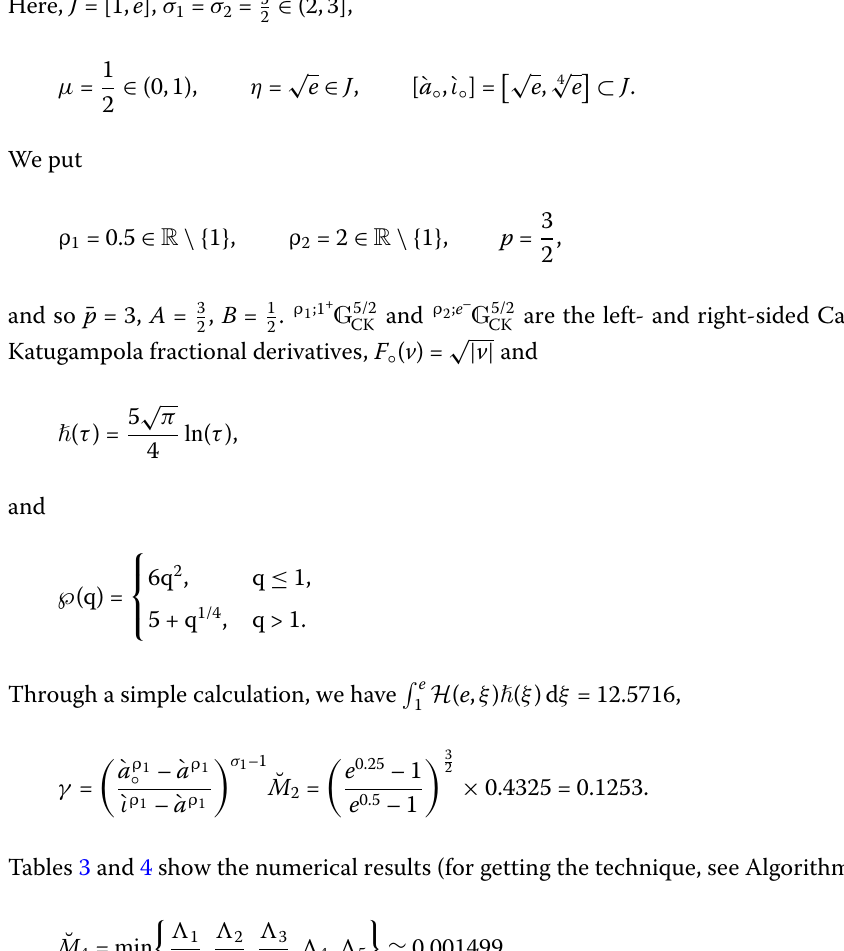
(cid:25) ` ι ` ι , ξ ) d ξ , ˘ M G 1 ( ` a